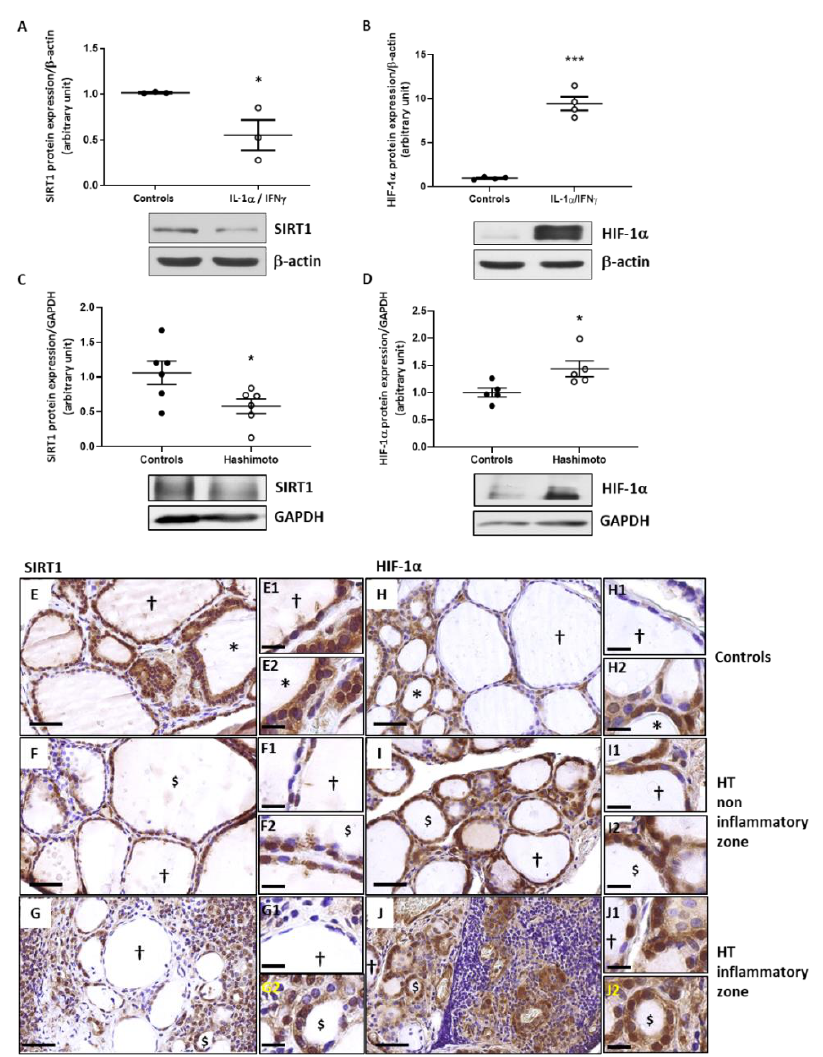
Figure 5. In Th1-HT context, SIRT1 was downregulated while HIF-α was upregulated. Addition of Th1 cytokines to primary cultures of human thyrocytes induced a significant reduction of SIRT1 ( A ) and an increase of HIF-1α protein ( B ). Densitometric values were normalized against the β-actin level. Results are expressed as means ± SEM from seven (SIRT1) and four (HIF-1α) experiments ( n = 4–7) at least in duplicate. SIRT1 protein expression ( C ) was significantly decreased in HT patients while HIF-1α ( D ) was increased. Densitometric values were normalized against the GAPDH level. Results are expressed as means ± SEM from five or six individual samples ( n = 5–6). * p < 0.05, *** p < 0.005 compared to controls. Representative blots are shown. Paranodular tissue from multin- odular goiter patients designated as controls ( E , H ) and HT thyroid samples ( F , G , I , J ) were used to perform IHC with SIRT1 and HIF-1 α specific antibodies. In controls ( E ), SIRT1 was detected in thyrocytes of hypofunctional follicles (†) and more intensively in active follicles (*). In HT ( F , G ), staining was less intense in altered active-like follicles ($). In control thyroids ( H ), HIF-1 α staining was observed in the cytoplasm of the thyrocytes († and *). In HT thyroids ( I , J ), non-inflammatory and inflammatory zones displayed hypofunctional (†) and altered active-like ($) follicles with strong staining of HIF-1 α in thyrocyte cytoplasm. Illustrations shown are representative of both conditions. ( E , J ) Scale bar = 50 µ m. ( E1 – J2 ) Scale bar = 20 µ